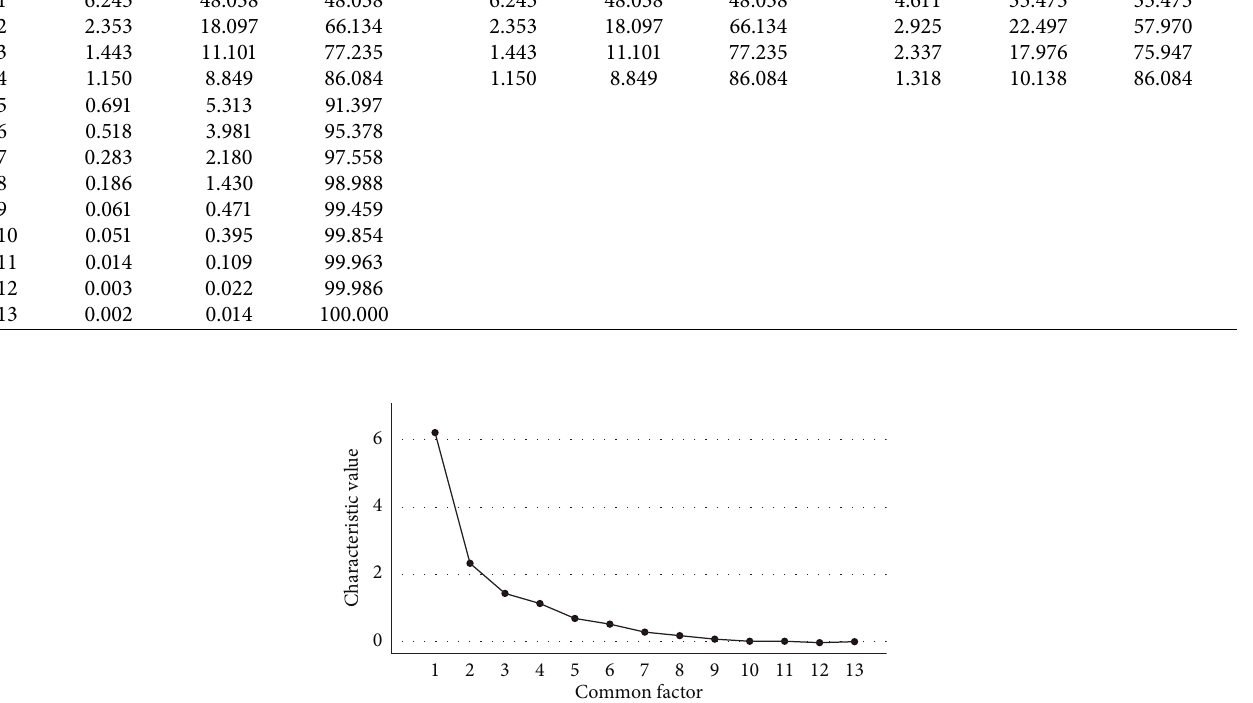
Figure 4: Factor analysis of incense burners in the Qing Dynasty gravel map. Table 6: Component matrix and composition score coefficient matrix of censers after rotation in the Qing